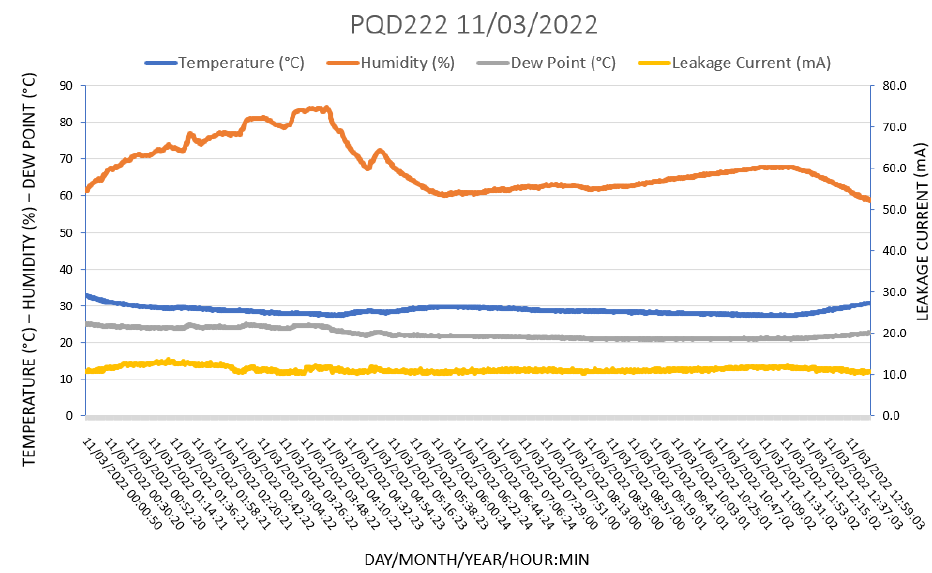
Figure 15. Favorable weather conditions in which the insulator remains at an average leakage current below 15 mA but no LC peaks are recorded, in particular, because the dew point is well below the local temperature.